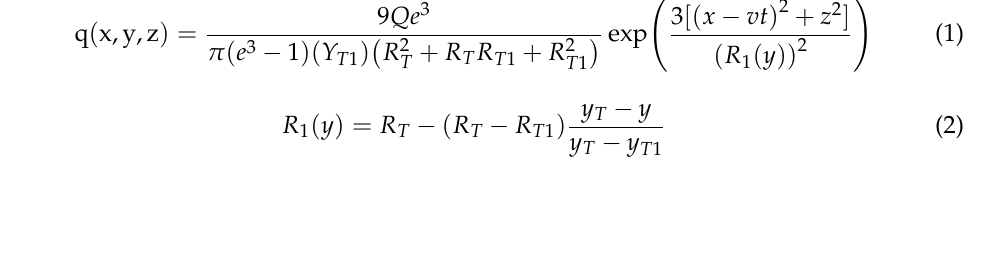
Table 2. Variables of heat source model.